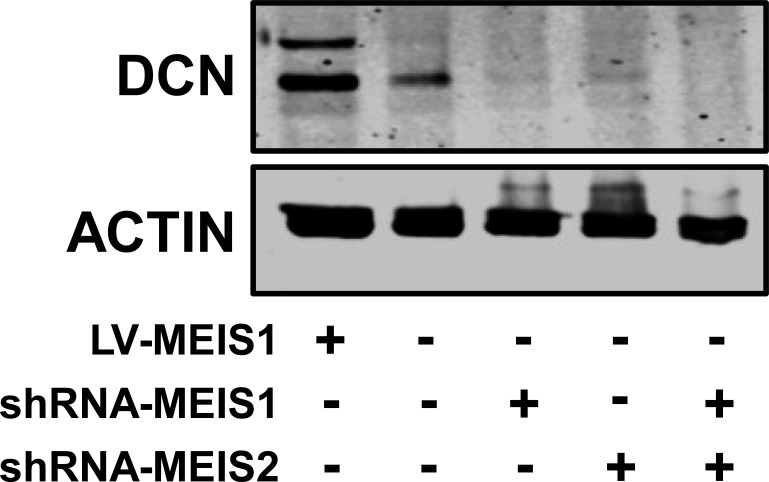
Functional impact of MEIS1 and DCN knockdown in LAPC4.Western blot of DCN demonstrating decreased DCN protein expression in LAPC4 cells when MEIS1, MEIS2, or both MEIS1 and MEIS2 are depleted using targeted shRNAs. These lines were originally reported in Bhanvadia et al., 2018. Positive control was LAPC4 expressing ectopic MEIS1, and Actin was used as a loading control.